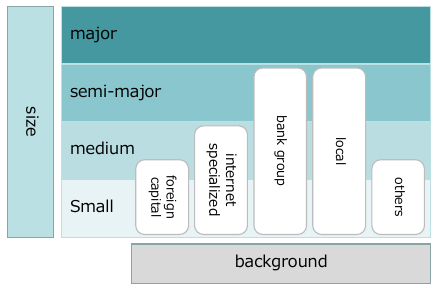
Figure 2. Categories of securities companies